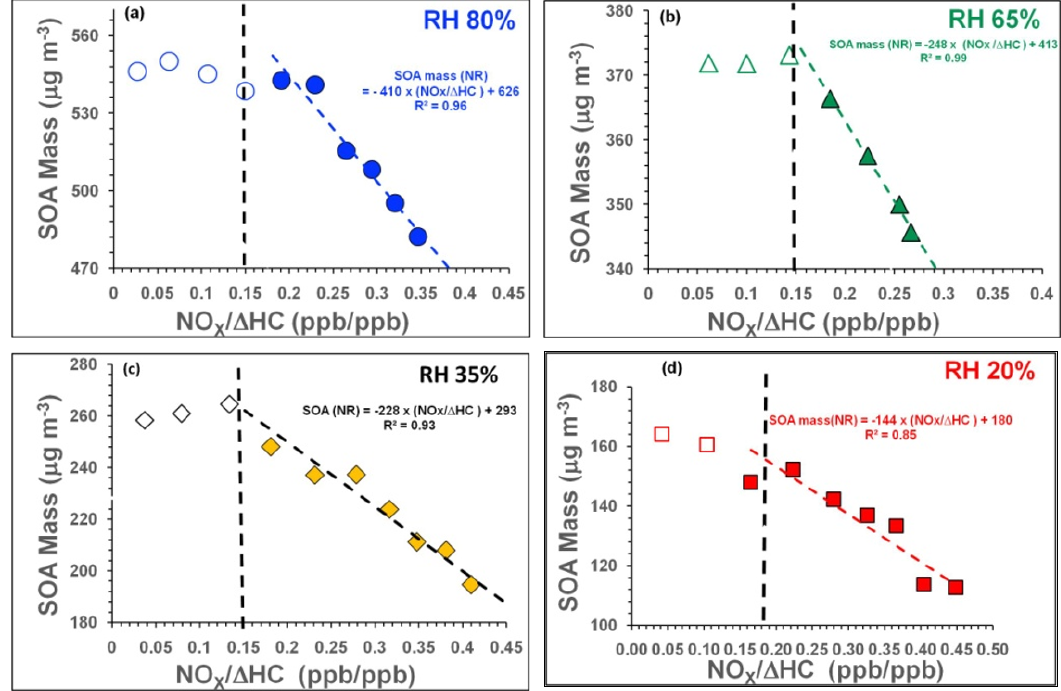
Figure 1. ( a – d ): SOA mass formed as a function of [NO x ]/[ ∆ HC] at ( a ) 80% RH, ( b ) 65% RH, ( c ) 35% RH, and ( d ) 20% RH. Empty and filled symbols show results for NP and NR SOA, respectively. Dashed lines are included to guide the eye.